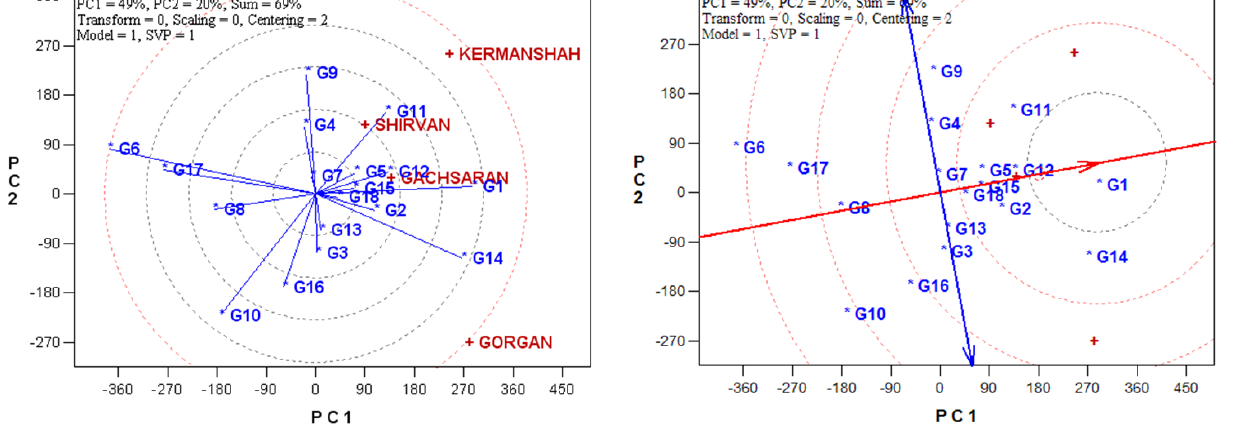
Fig. 5. GGE biplot of ideal genotype and comparison of the genotypes with the ideal